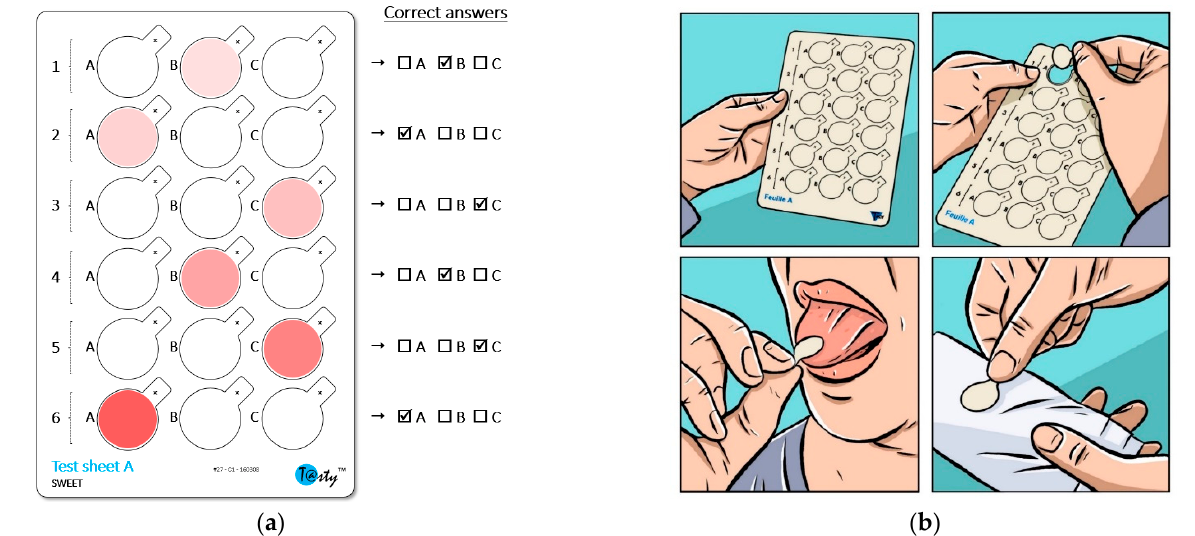
Figure 2. ( a ) An example of a test sheet (allowing for one sensitivity measurement to a given taste). The color symbolizes the location of the tasty discs and the increasing intensity of the taste intensity. Dimensions of the sheet: 11 × 16 × 0.06 cm. Discs: 18 mm in diameter and 2.54 cm 2 in area. ( b ) The procedure for detaching and tasting the discs was as follows: detach the disc from the test sheet by holding it by the gripping tab, put the upper face of the disc (marked with a small cross) in contact with the tip of the tongue (first third) for a maximum of 4–5 s, and then discard the disc. After a short pause (10 s), subjects could evaluate the next triplet of discs.